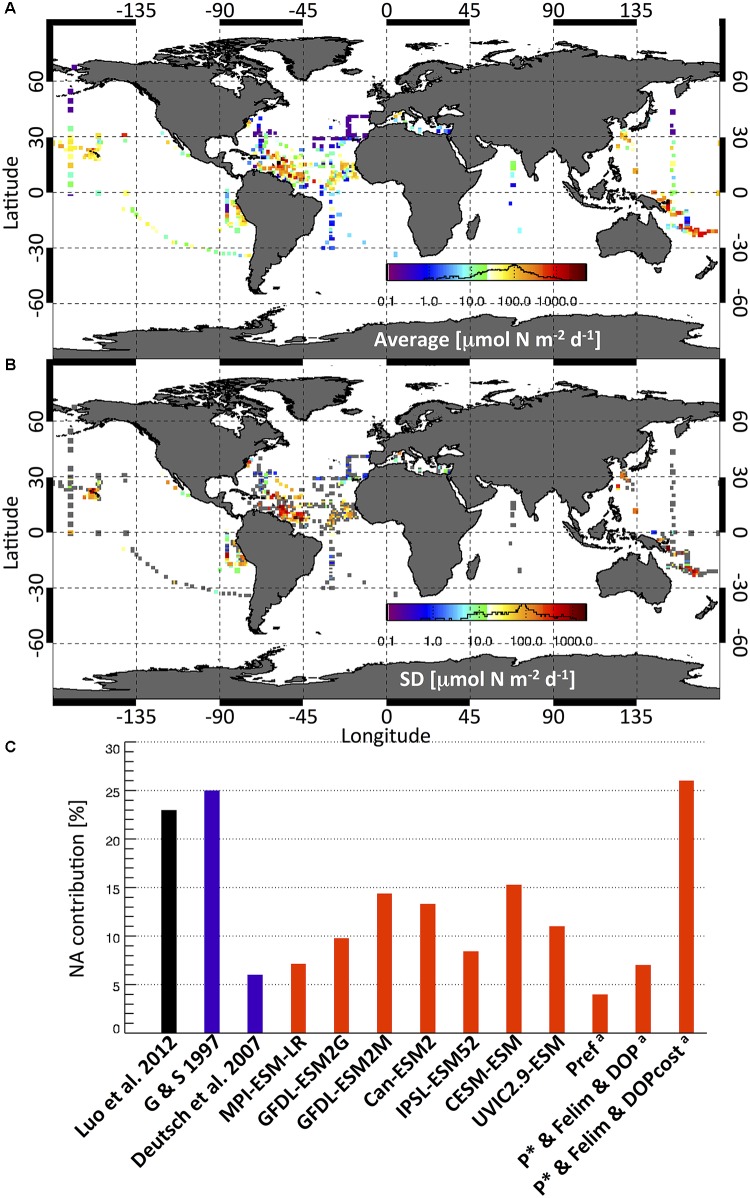
1 × 1 degree grid (A) average and (B) standard deviation (SD) of depth integrated N2 fixation rate (μmol N m−2 d−1) experimental measurements from the MAREDAT database (Luo et al., 2012) and 800 additional data points (see text for details). Gray squares in SD plot indicate one-only data point. Data distribution histogram is shown in the color bar. (C) Experimental (black)-, geochemical (blue)-, and model (red) -based estimated contribution (%) of the North Atlantic to global N2 fixation rates. Models include those of the Coupled Model Intercomparison Project (CMIP5, see Table 1), a model with additional energetic costs of DOP uptake (UVIC2.9-ESM, Landolfi et al., 2017) and amodel experiments of Landolfi et al. (2015) accounting for preferential phosphorus remineralization (PREF), P∗ and iron limitation and DOP uptake without (P∗ and Fe and DOP), and with additional energetic and also N costs (P∗ and Fe and DOPcost).